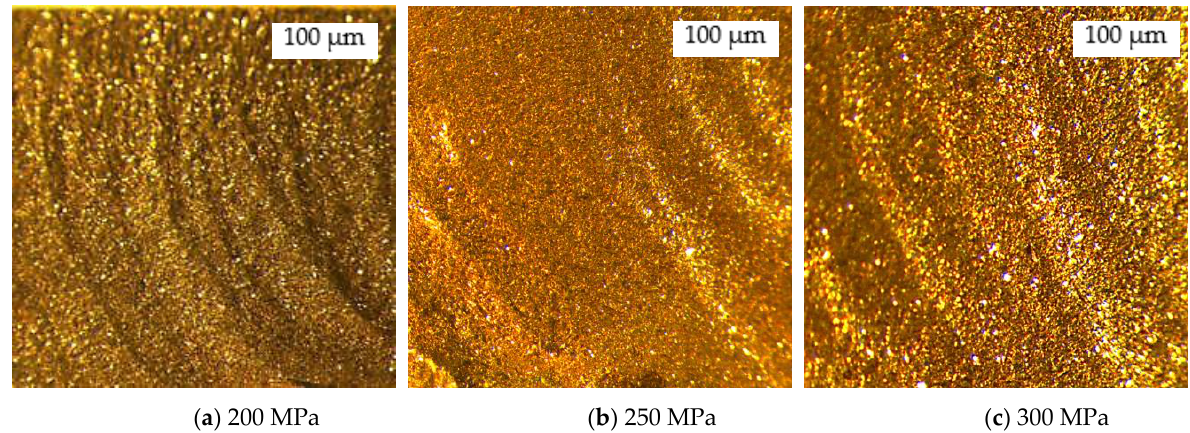
( c ) 300 MPa Figure 9. Topography of AISI 304L cut surface with 12 mm thickness using varied waterjet pressure.